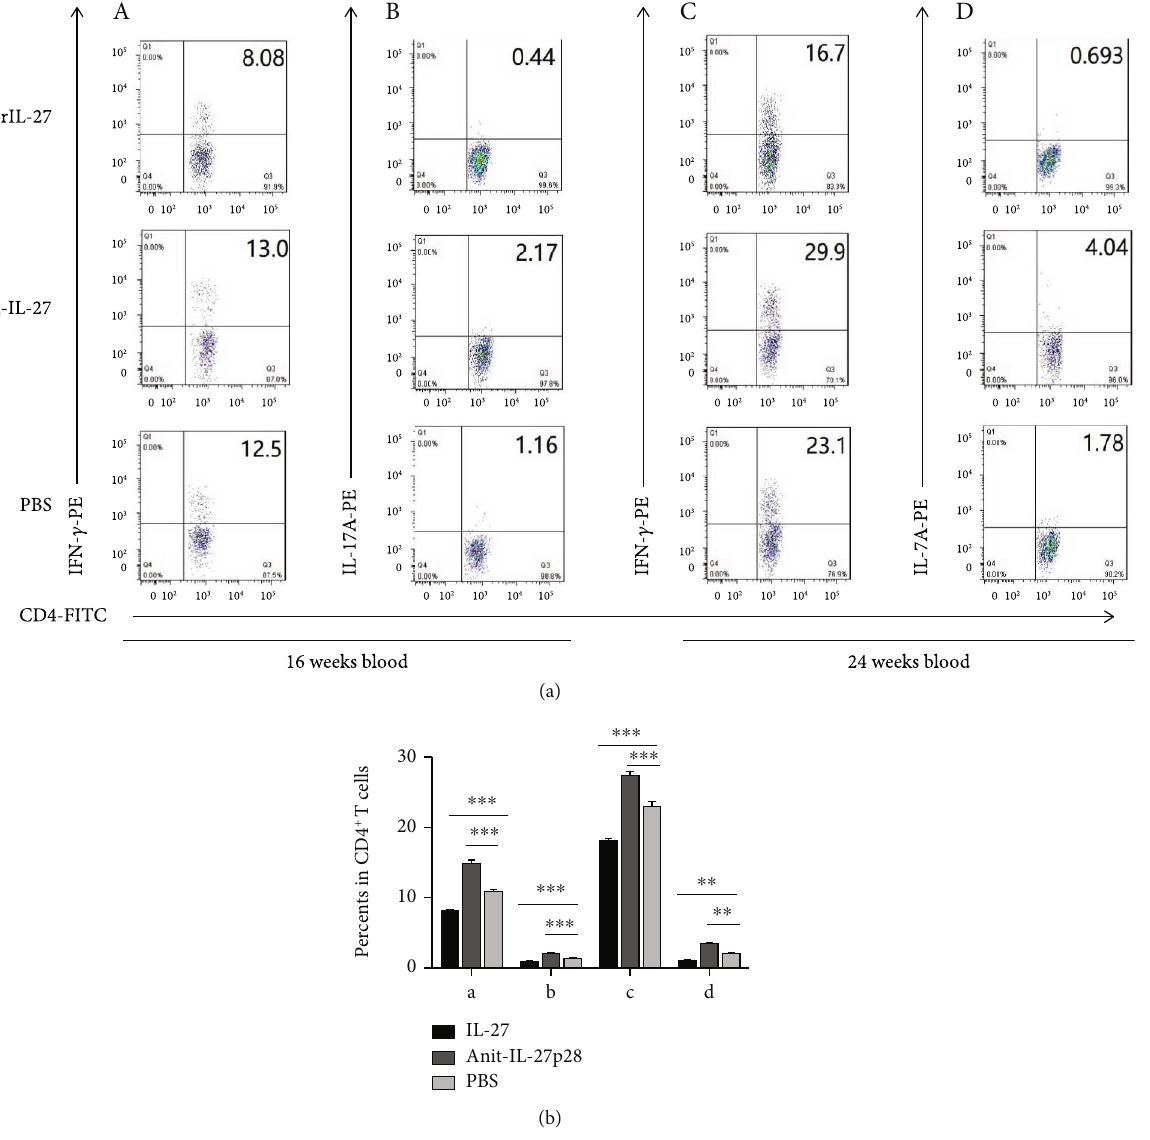
Figure 6: Recombinant IL-27 reduced the fractions of Th1 and Th17 cells in the blood of ApoE -/- mice. (a) In the blood, the fractions of Th1 and Th17 cells were measured by fl ow cytometry. (A) and (B) show the fractions of Th1 (A) and Th17 cells (B) during the initiation of atherosclerosis. (C) and (D) show the fractions of Th1 (C) and Th17 cells (D) during the progression of atherosclerosis. (b) Groups data are shown in histogram. ∗∗∗ P < 0 : 001 , ∗∗ P < 0 : 01 , ∗ P < 0 : 05